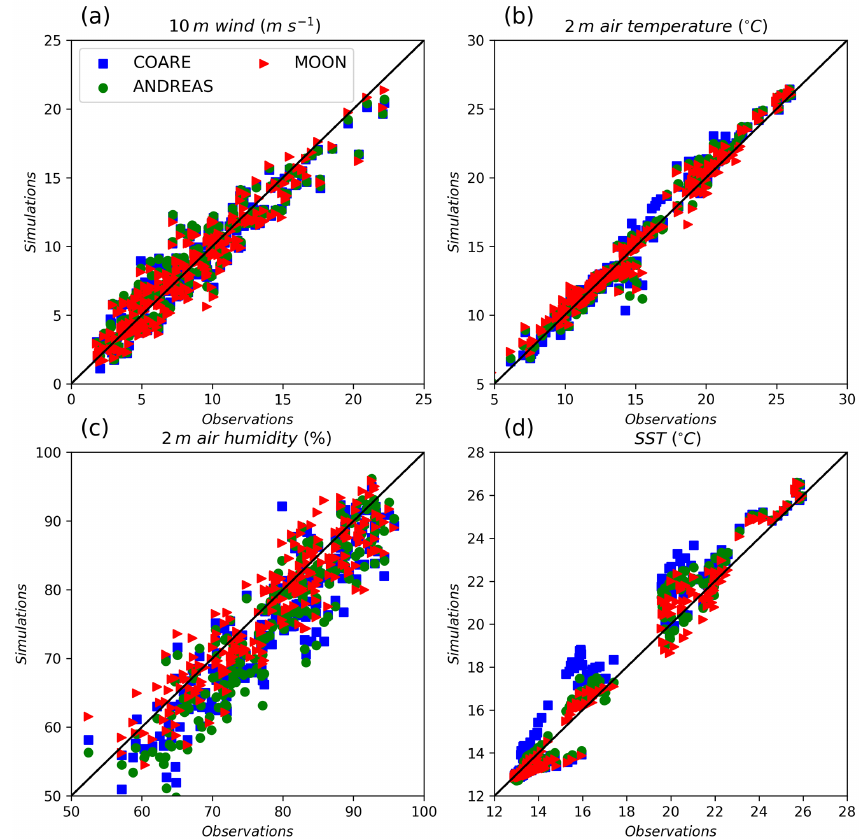
Figure 5. Scatter plots of simulations against observations at the Lion buoy for (a) the 10m wind speed, (b) 2m air temperature and (c) humidity, and (d) sea surface